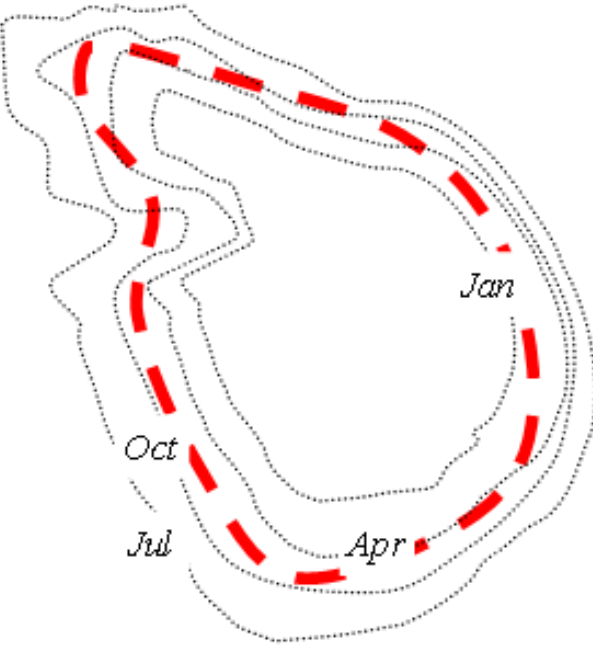
Figure 8. A lake as an example of